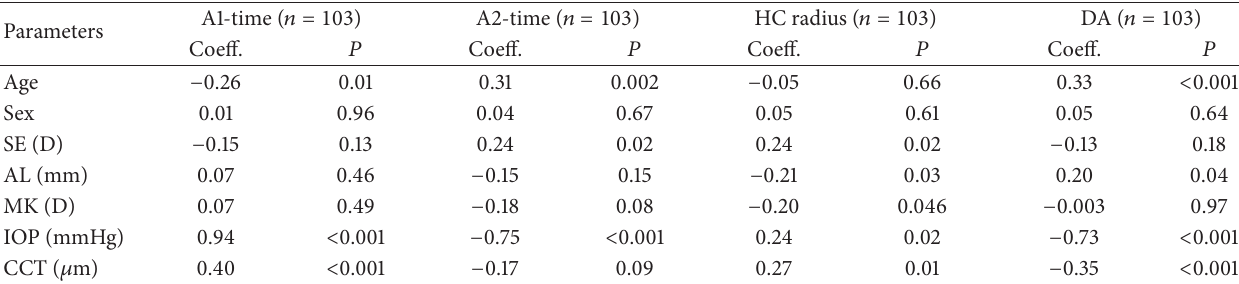
Table 3: Factors associated with corneal parameters with bivariate correlation